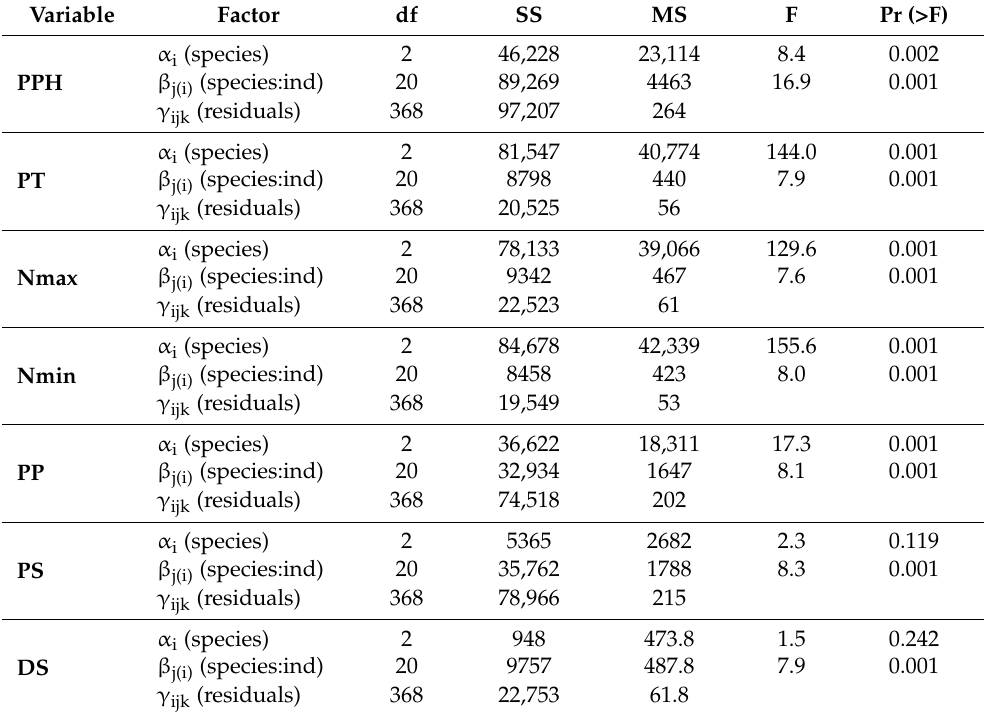
Table 1. Summary of the ANOVA results for the model expressed in Equation (1) and the quantitative variables described in Table 2. df: degrees of freedom; SS: sum of squares; MS: mean square; F: value of the